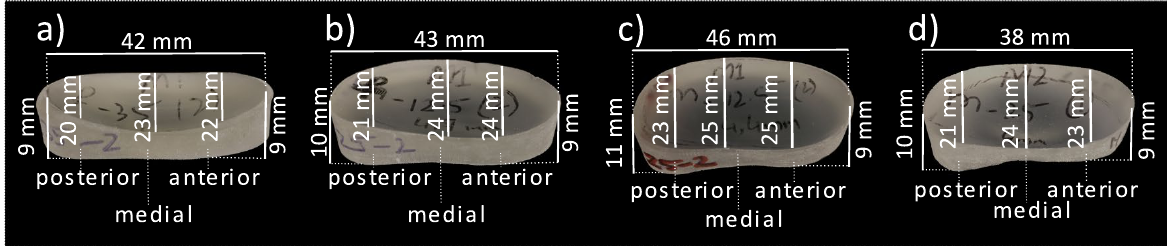
Figure 2. Spacer dimensions. Depiction of the four different spacers A–D and their muscle pulled with a constant force of 700 N during the flexion–extension knee motion, while the medial and lateral hamstrings exerted a constant force of 250 N, simultaneously 20 . A Teflon rope was attached to the inser- tion of the patella tendon to simulate the quadriceps muscle, and two to the ischium for the anatomical origins of the hamstring muscles. Joint contact stresses (JCS) and joint contact areas (JCA) were measured using thin and flexible Tekscan pressure sensor sheets (K-Scan™, PMS 4000, 900psi, Tekscan Inc., US). The width of the sensing matrix on every compartment is 27.9 mm and the height is 33.0 mm. Each sensor was calibrated and equilibrated using a ZWICK system (Zwick 020, Zwick GmbH & Co. KG, DE). The Sensor calibration was conducted by applying the Two Point Power Law calibration with regard to the manufacturer’s recommendations prior to testing 21 . The manufacturer’s software TestXpert V10.0 was used to create the loading protocols. Four different spacers (Fig. 2) were developed and manufactured (be innovative GmbH, Cologne, Germany) in a polyurethane (PU) pressing process using their own aliphatic polyurethane (shore-A hardness 70–73). To determine what spacer designs best fit the anatomical range of the study population, a form-finding process was deduced using SSM of anatomical knees derived from the OAI database 22 . A subset of 507 datasets, represent- ing all grades of OA according to the Kellgren & Lawrence 23 classification was selected and segmented using an SSM-based approach, trained on the public SKI10 dataset 24 . All segmentations were carefully revised and manu- ally corrected in cases where necessary. The resulting segmentation masks (femur, tibia as well as the respective cartilage) were made publicly available as an OAI-ZIB dataset 25 . Further details on demographic aspects and segmentation procedures can be found in Seim et al. 26 and Ambellan et al., respectively 25 . The SSMs for all bones were generated via a consistent surface decomposition and a common parametrization resulting in a set of cor- responding vertices for each bone segment 27 . These sets of vertices for all knees were transformed via principal component analysis into a point distribution model that is represented by the mean geometry of the respective anatomical structure together with statistical modes of geometric variation 19 . The determined SSM mean shape knee model was used to fit a corresponding spacer shape in the medial knee joint gap by the planning tool. Since variations in the spacer can have different effects on the distribution of loads, four variations were created based on the mean shape. The four spacers are reniformed to prevent tilting at the Eminentia Interkondylaris (Fig. 3). Specifically, they can be divided into two groups to differenti- ate: spacer C and D are designed for larger knee geometries and are larger in length, width, and thickness than the other two spacers (spacer A and B). Regardless, all of the four spacers vary in that the planes of the bottom and top are inclined differently from one another. All spacers are concave on the top and bottom. The rear and front parts of the spacer surfaces show a different elevation and a different gradient angle of the elevation. These differences in the spacer geometry are intended to show in the application whether there are differences in the effect of the pressure distribution. Prior to testing the four spacers in every artificial knee geometry, the 3D printed knee models were mounted into the joint loading simulator and the muscle tracts were attached to the corresponding anatomical landmarks. Tekscan sensors were inserted anteriorly to posteriorly on the medial and lateral side of the tibial plateau, between the articulating surfaces of the femur and tibia. An adhesive tape was stretched on the bottom of the sensors and attached to the 3D printed tibial plateaus to ensure the fixation of the sensors throughout the testing procedures. To investigate the effects of the spacers in the different knee geometries in simulated dynamic flexion–exten- sion movements, each of the four spacer templates was inserted in the medial condyle of each 3D printed knee model (Fig. 3). Furthermore, an additional condition was performed with no spacer inserted. Data was collected at 50 Hz (I-Scan System, Tekscan Inc., US). The average of 27 flexion–extension cycles was used for the analysis within a movement range of 5–90°. Pressure data was time-normalized to the flexion–extension phase. Data processing was conducted with custom-built Matlab (2019a) routines (The MathWorks, Natick, USA). Force and area were calculated by reference to the tekscan pressure maps (F = kPa*area; area = sum of the loaded Tekscan cells. Force peak: Peak force/Frame. Mean stress: (Sum stress/loaded cells)/Frame). Descriptive statistics are presented in this study for all considered variables due to the small sample size, including the average values for maximum peak pressure (MPP) and mean pressure (MP), contact force, and area of loaded sensors, as well as the corresponding standard deviations. Furthermore, 95% confidence intervals (CI) were calculated for the no-spacer condition based on the one-dimensional time series analysis proposed by Pataky et al. 28 using the open-source spm1d package (Version M.0.4.5, www. spm1d. org) in Matlab (2019a). Ethics statement.